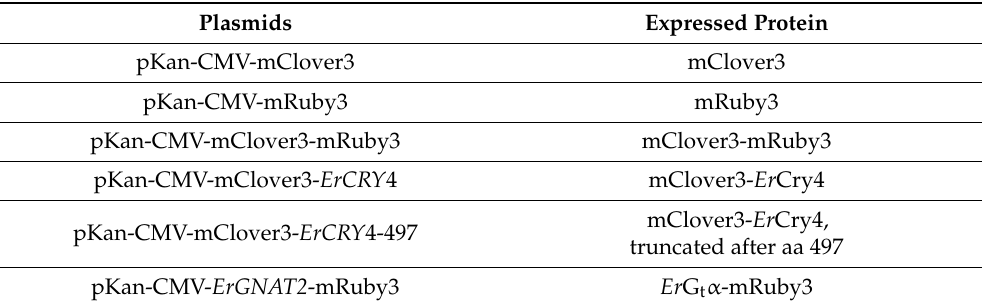
Table 1. Overview of FRET plasmids and expressed